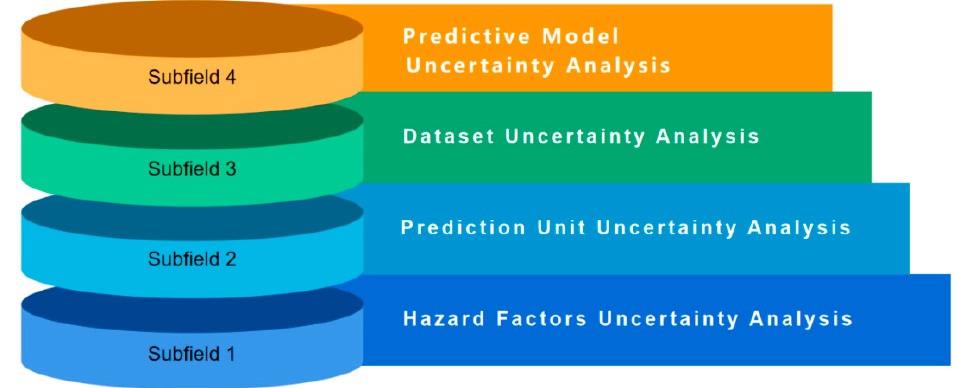
Figure 14. Subfield